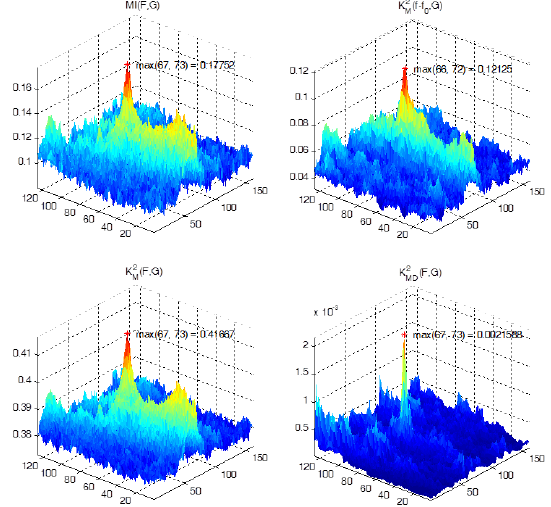
Figure 7. Example 3: a) etalon TV fragment; b) test IR image; c) segmented TV fragment.